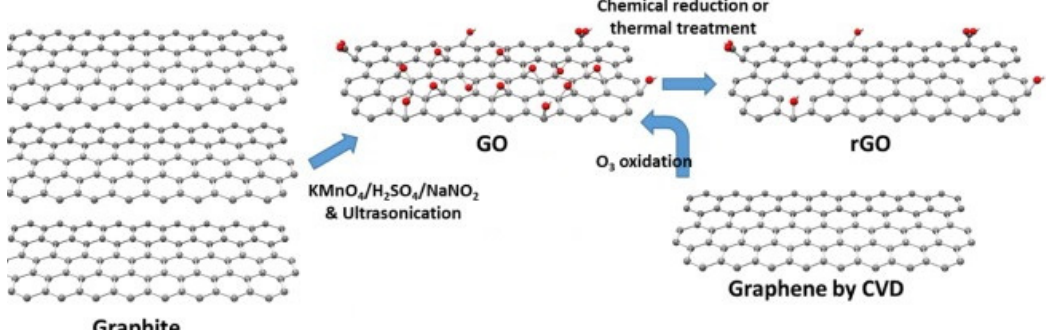
Figure 4. Structure and preparation of GO and rGO [44].